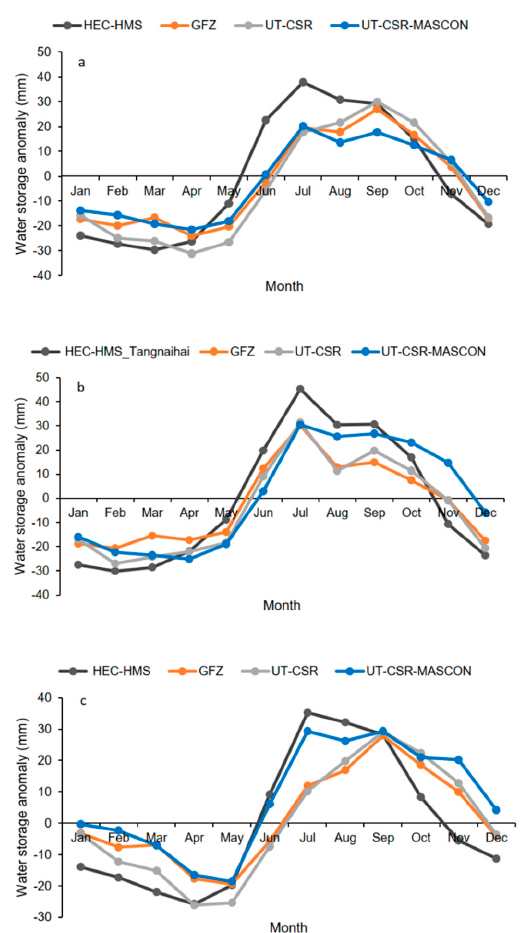
Figure 10. Comparison of water storage anomalies with the GRACE data in ( a ) the SLR, ( b ) SYER, and ( c ) SYAR, for the period 2002–2015.